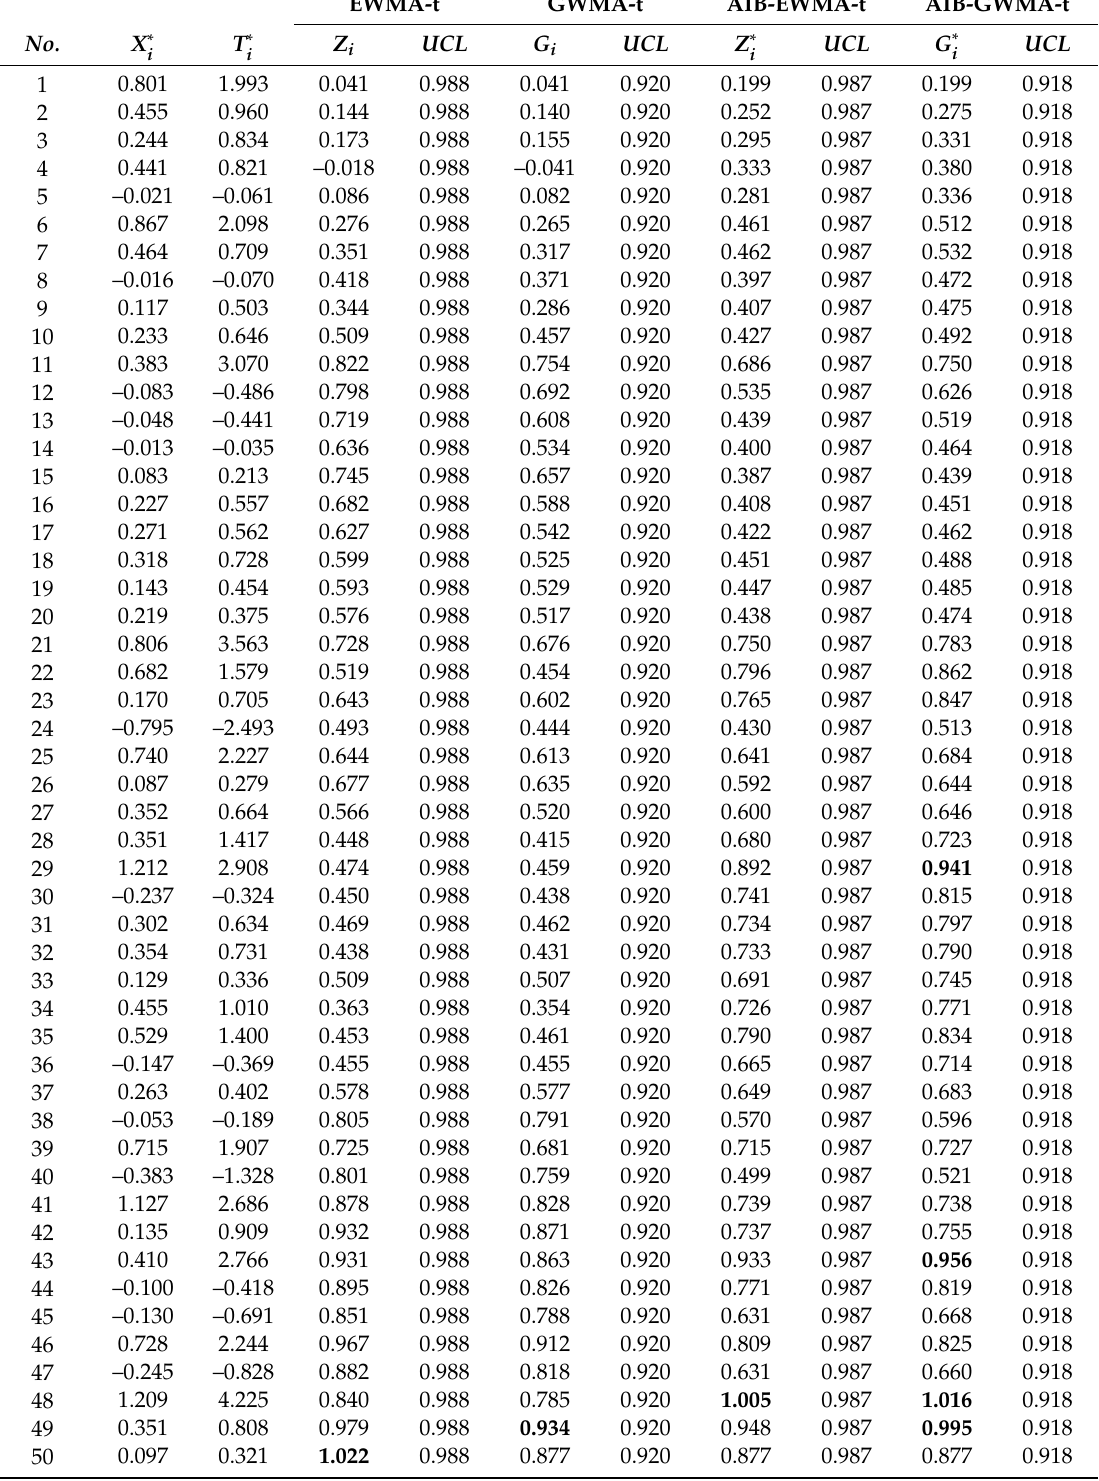
Table 6. Simulation dataset of the EWMA-t and GWMA-t charts when ρ = 0.0 and AIB-EWMA-t